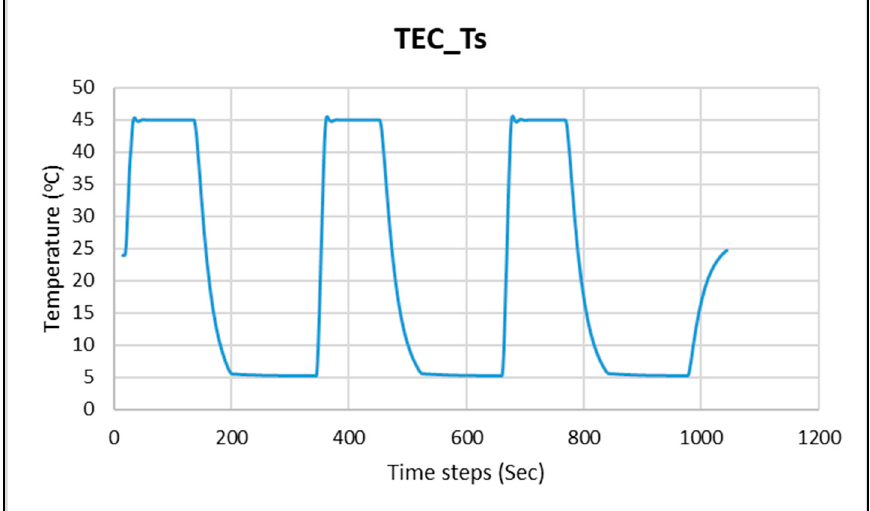
Figure 10. Heating and cooling performance with the tuned controller.